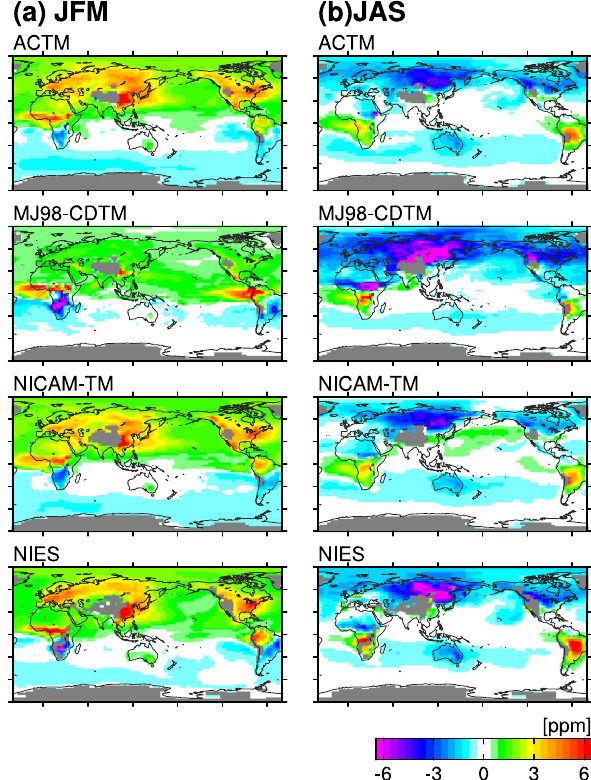
Fig. 4. Seasonal mean vertical difference of CO 2 between 850hPa and 500hPa for JFM (a) and JAS (b) of 2007, simulated by ACTM (uppermost panels), MJ98-CDTM (middle upper panels), NICAM- TM (middle lower panels), and NIES (lowest panels) using Flux2. Positive values mean that the CO 2 concentration at 850hPa is larger than that at